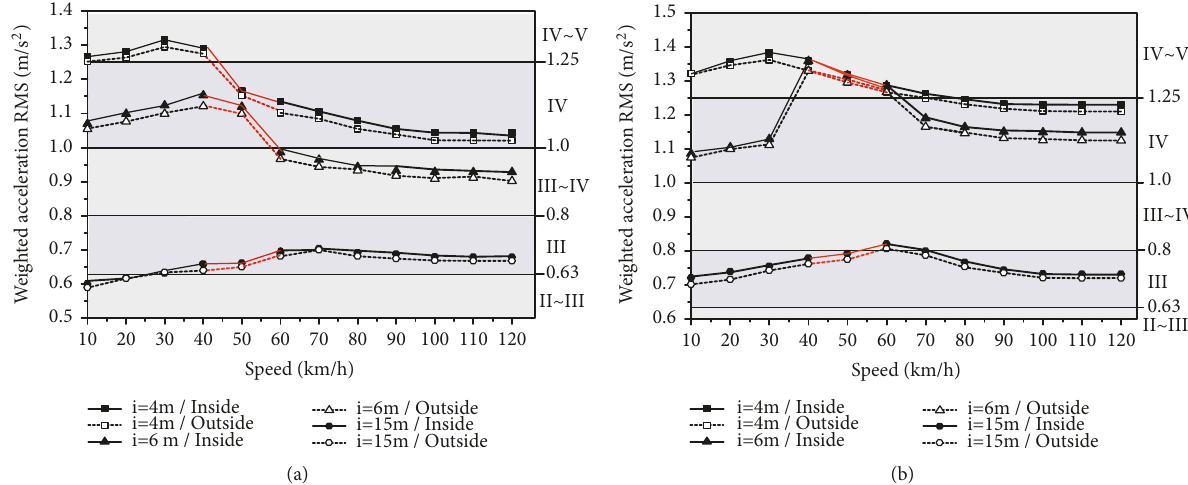
Figure 7: The combined total weighted acceleration RMS for the curved ramp section between 10 km/h and 120 km/h: (a) the curved ramp section (car); (b) the curved ramp section (semi-trailer truck).